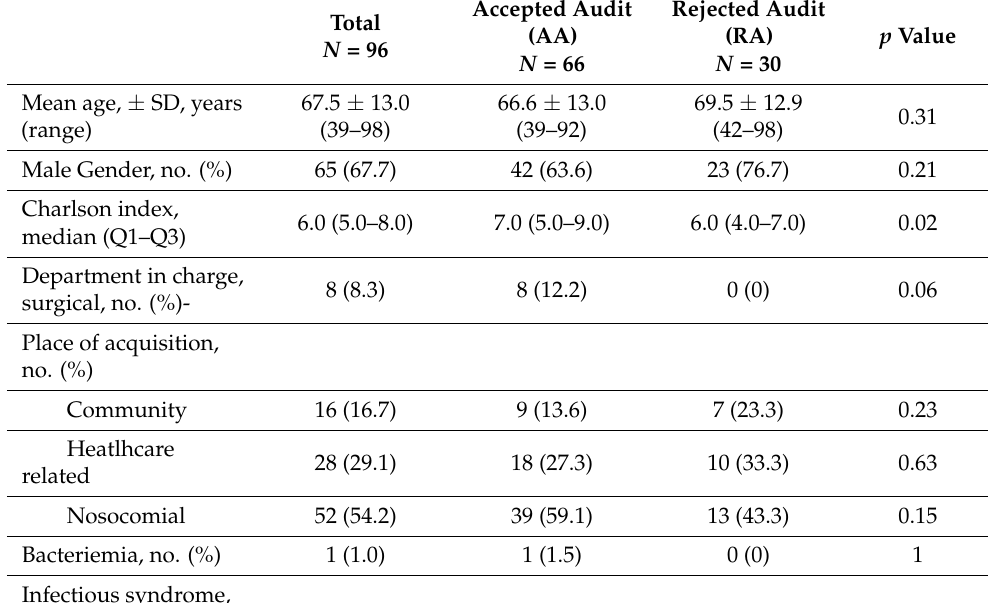
Table 1. Demographics and clinical characteristics in the admission of patients with inappropriate meropenem prescriptions according to the follow-up on the recommendations conducted by the ASP